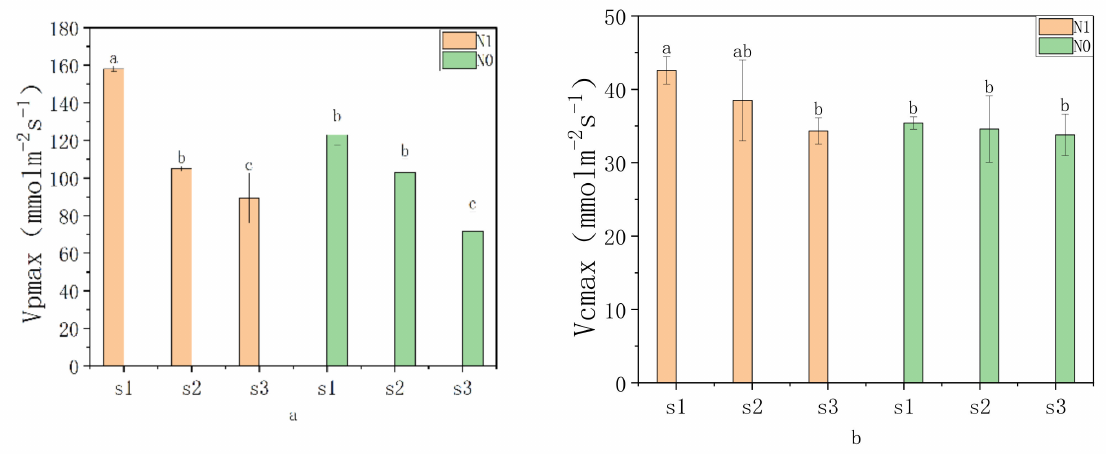
Figure 7. Effects of different nitrogen (N) and salt (S) treatments on V pmax , the maximum carbon fixation rate of PEP ( a ) and V cmax , the maximum carbon fixation rate of Rubisco ( b ) at the stage of V12. The ANOVE results are given for each S and N. Values are means ± SD per treatment. Different letters indicate statistically significant ( p < 0.05) differences between the treatments using a Tukey post hoc test. N1 is nitrogen application, and N0 is no nitrogen application. S1, S2 and S3 are the soil salinity concentrations of 0%, 0.1% and 0.25%,